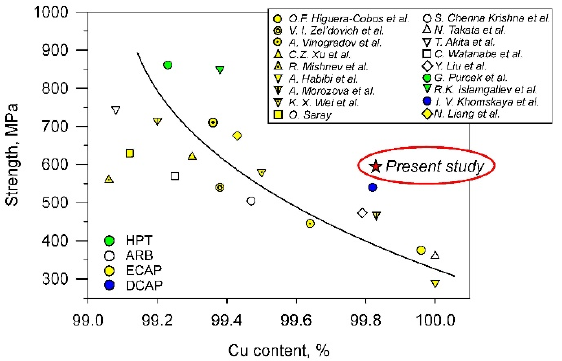
Figure 9. Relationship between the strength and the alloying content in copper alloys subjected to severe plastic deformation [4,5,8,29,39,68–80]. severe plastic deformation